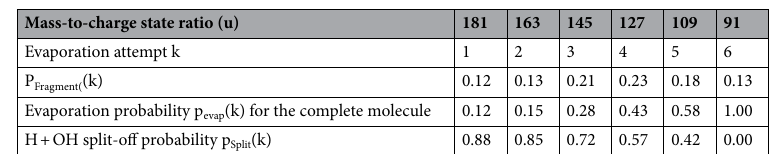
Table 2. Calculated evaporation and split-off probability of the glucose molecules assuming a simple multi- step random process.